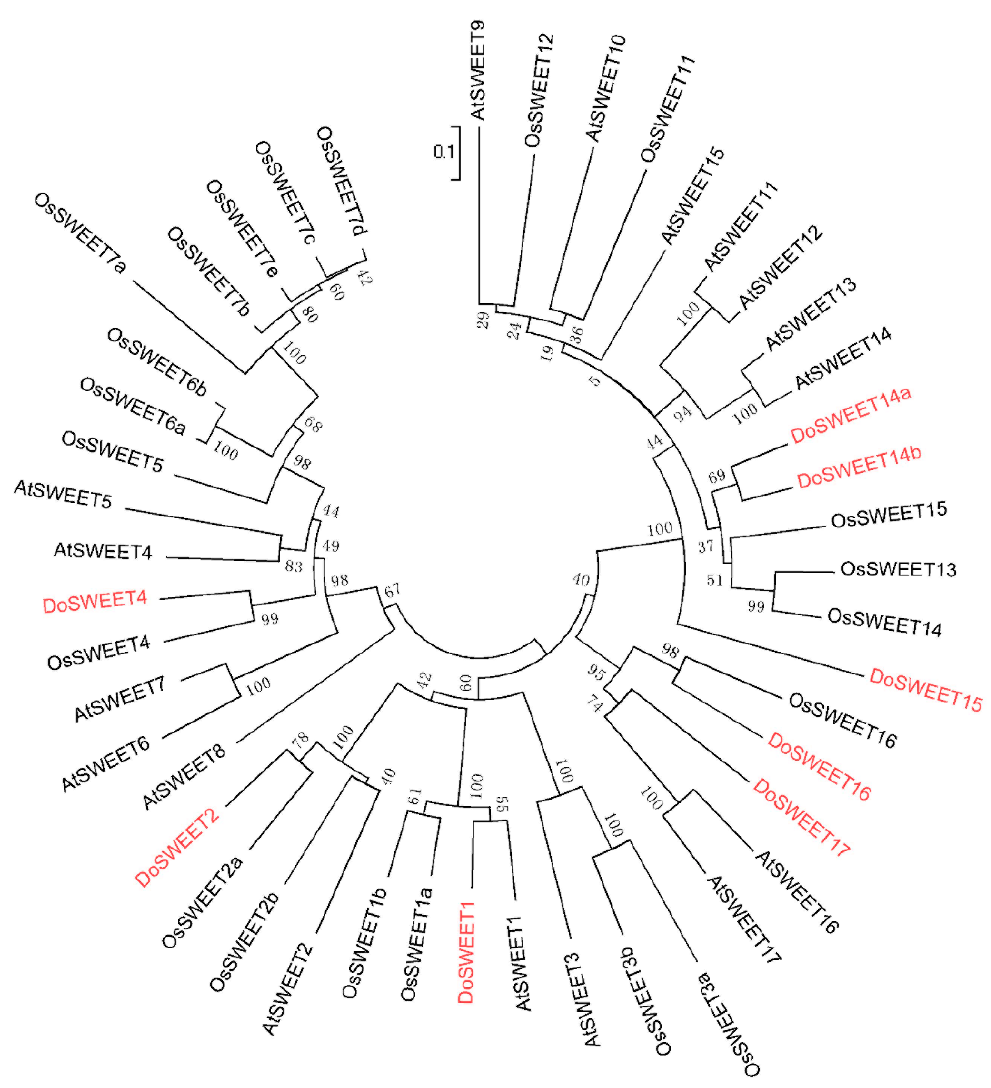
Figure 5. Neighbor-joining phylogenetic tree of sugars will eventually be exported transporters (SWEETs) from D. officinale , Arabidopsis , and rice. This analysis comprised amino acid sequences for 17 AtSWEETs, 21 OsSWEETs, and 8 DoSWEETs (in red).